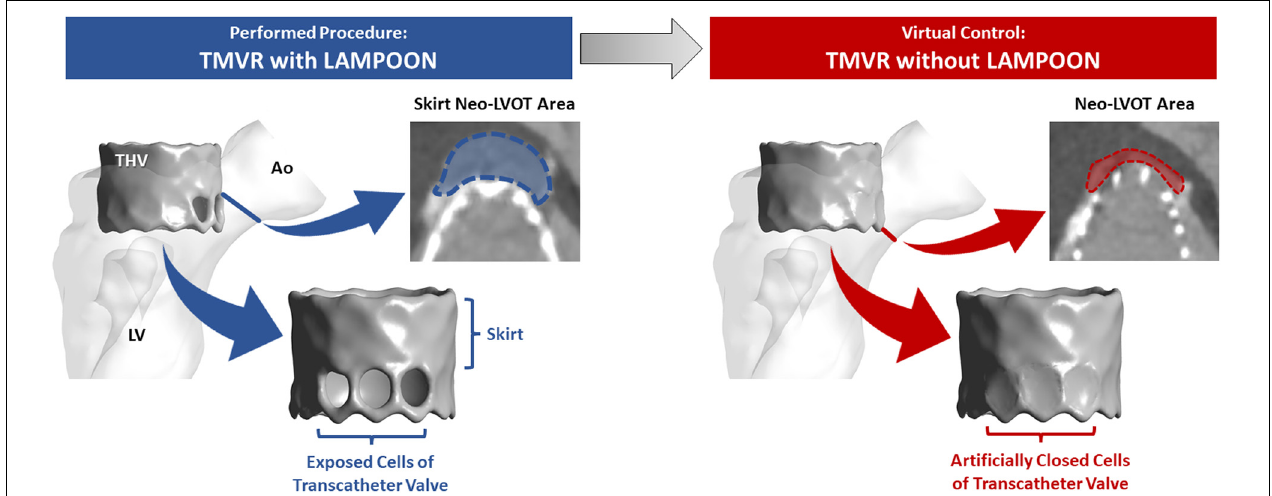
FIGURE 1 | 3D anatomical models created for each subject. The left model represents the actual performed procedure (TMVR with LAMPOON). In this model, the left ventricular anatomy and implanted transcatheter valve geometry were segmented directly from the post-procedure CT dataset. The number and location of transcatheter valve cells exposed by LAMPOON were modeled based on visualization of the anterior leaflet splay in the post-procedure CT dataset. To simulate a “virtual control” procedure in which LAMPOON was not performed (TMVR without LAMPOON), we artificially closed the exposed cells of the transcatheter valve as shown in the right model. Ao, aorta; LV, left ventricle; THV, transcatheter heart